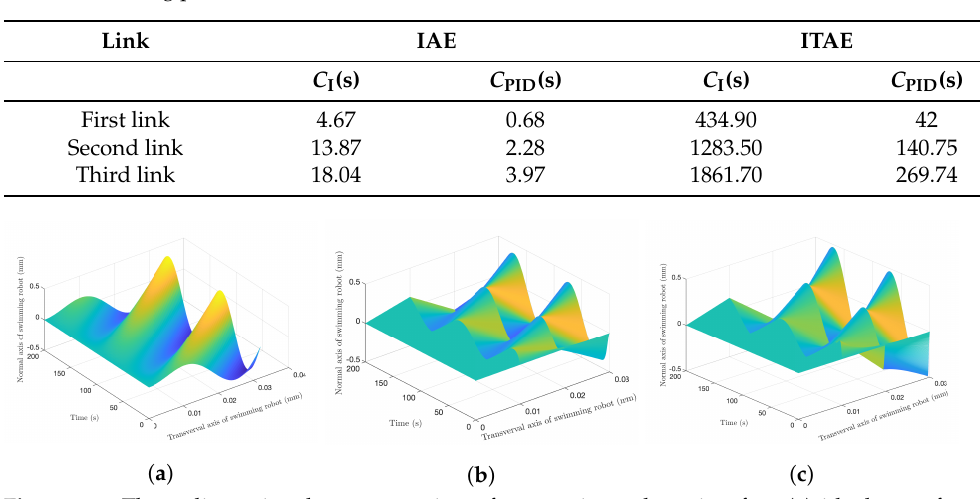
Table 5. Tracking performance indices.